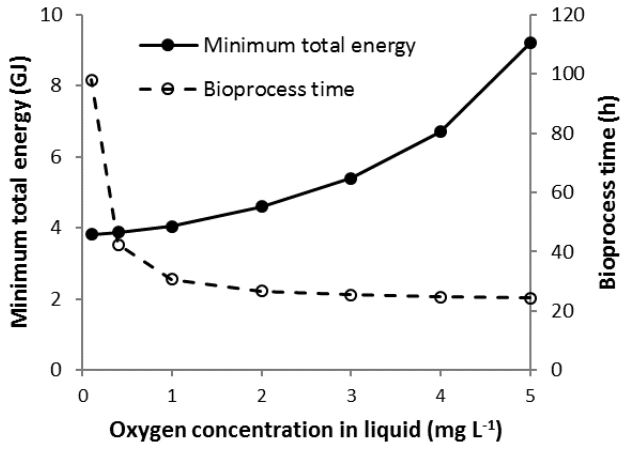
Figure 7. Scenario C1: Influence of oxygen concentration in the liquid on minimum total electric energy requirement.